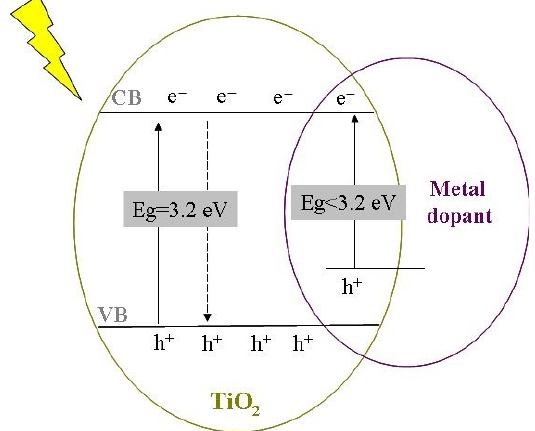
Figure 1. Schematic representation of bandgap narrowing by TiO 2 doping.